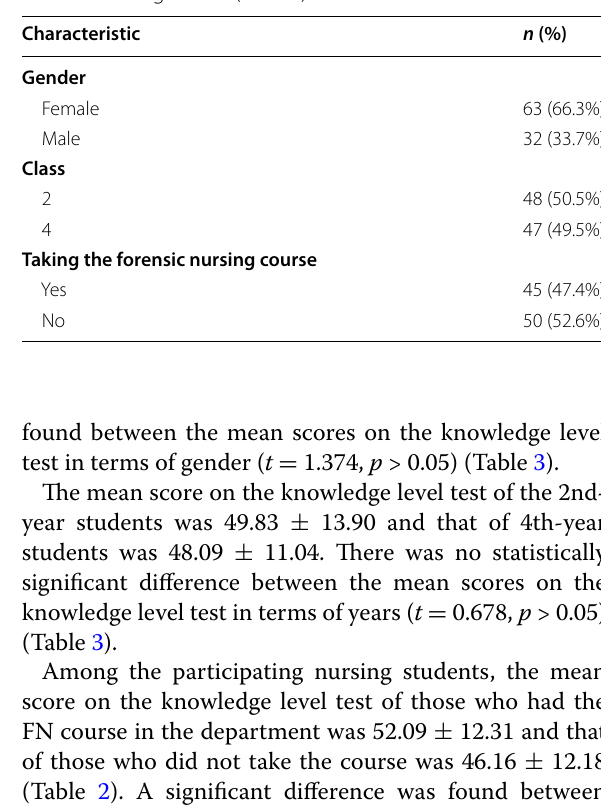
Table 1 The relevance ratings on the item scale by two experts Expert 1 Expert 2